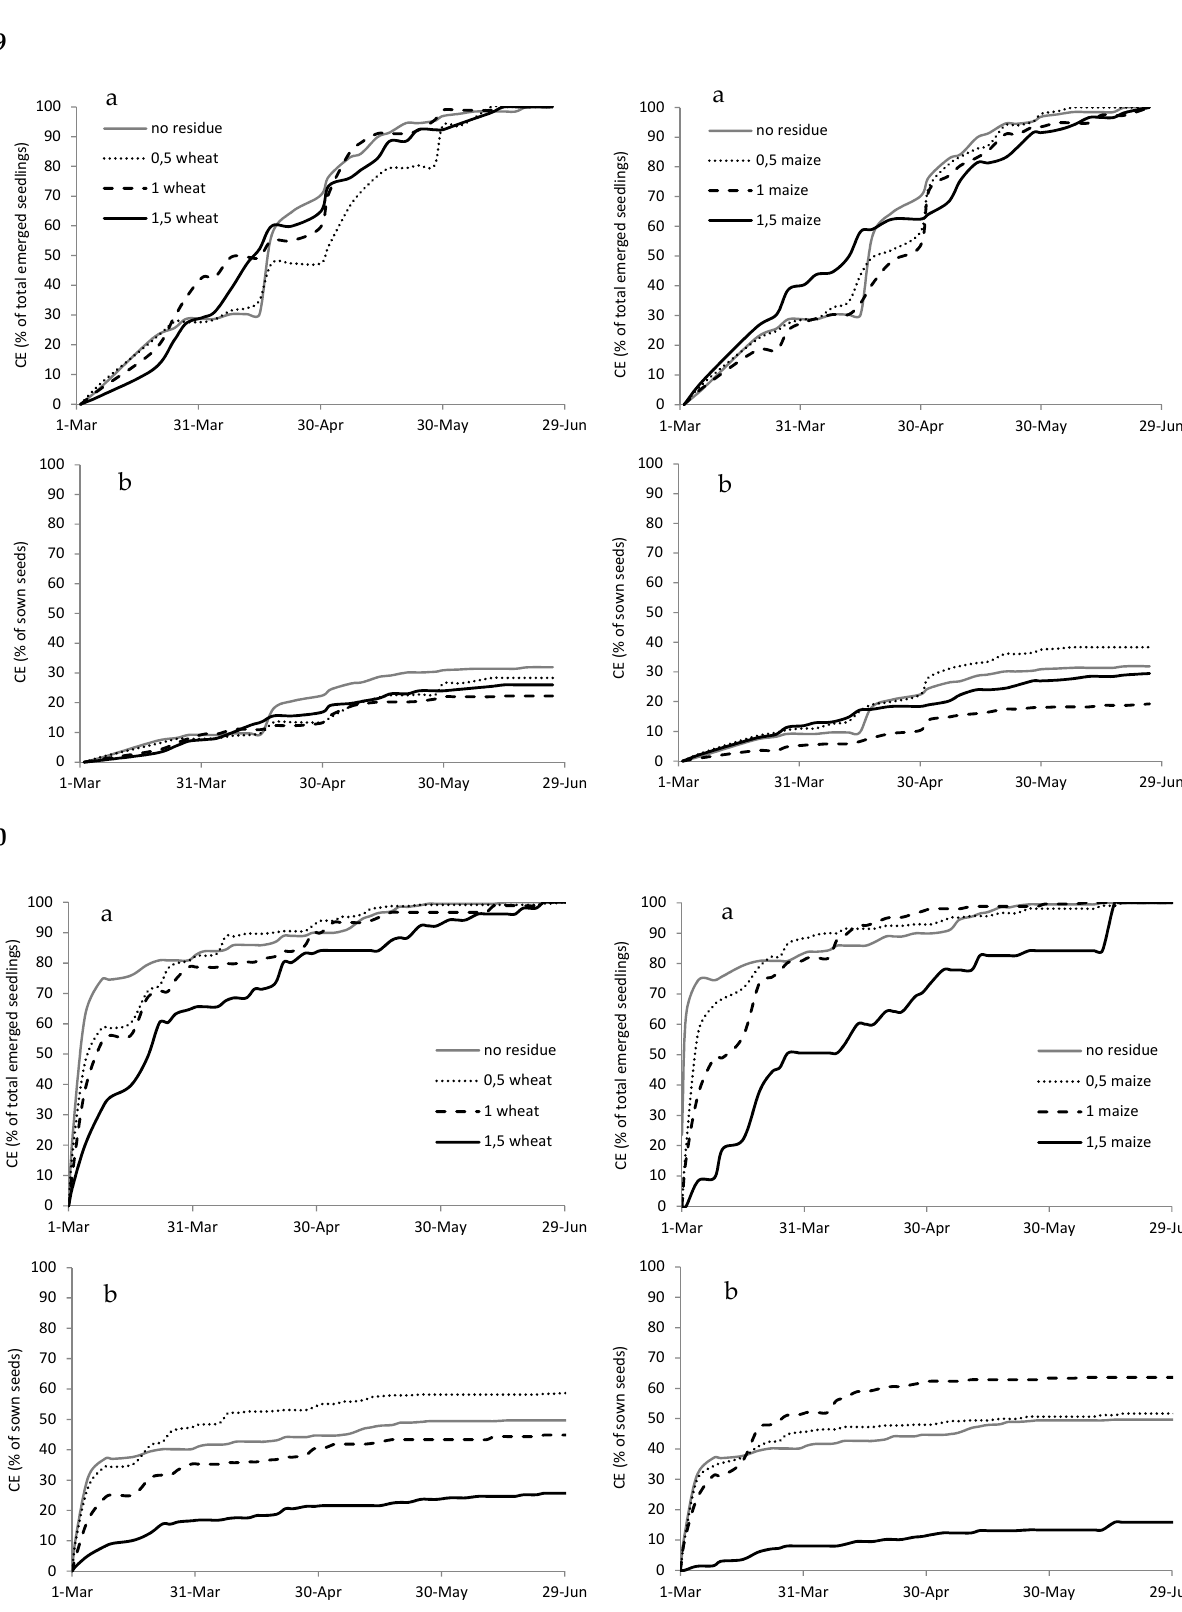
Figure A6. Cumulated emergence (CE) expressed as percentage of total emerged seedlings ( a ) and as percentage of sown seeds ( b ) of Setaria pumila in 2019 and 2020 with different types (wheat on the left and maize on the right) and amounts of crop residues.